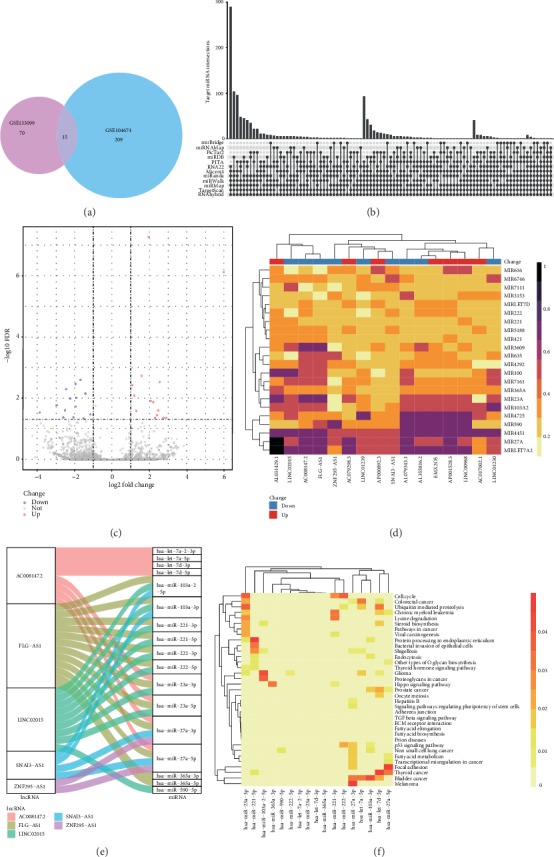
Identification of mRNA-miRNA and lncRNA-miRNA interactions. The downregulation significant DEmRNAs of GSE104674 and GSE133099 intersection was visualized by Venn plot (a). The mRNA-miRNA interactions predicted by miRWalk 2.0 were visualized by UpSet plot (b). The volcano plot of significant DElncRNAs (c). Correlation analysis between lncRNA and miRNA based on MIC (d). The lncRNA-miRNA interactions were visualized by alluvial diagram (e). KEGG pathway analysis for target miRNA (f).